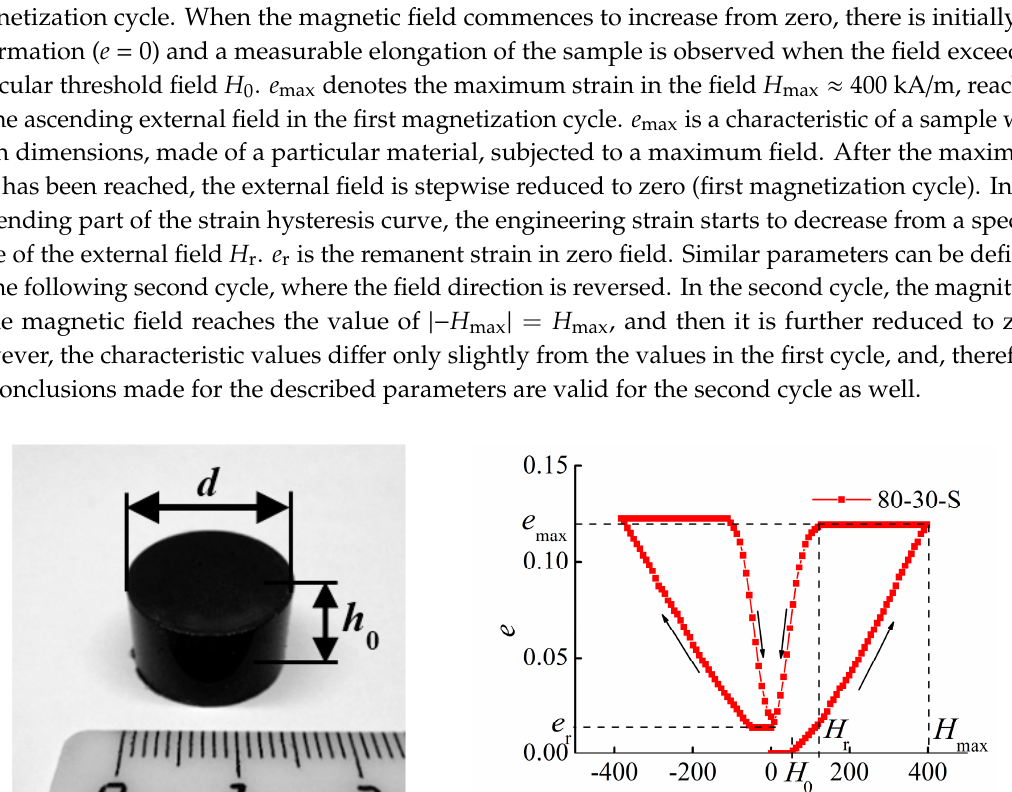
Figure 2. ( a ) Photograph of a sample with dimensions. ( b ) The engineering normal strain e = ∆ h / h 0 as a function of the applied magnetic field H . The arrows denote the direction of the field change.